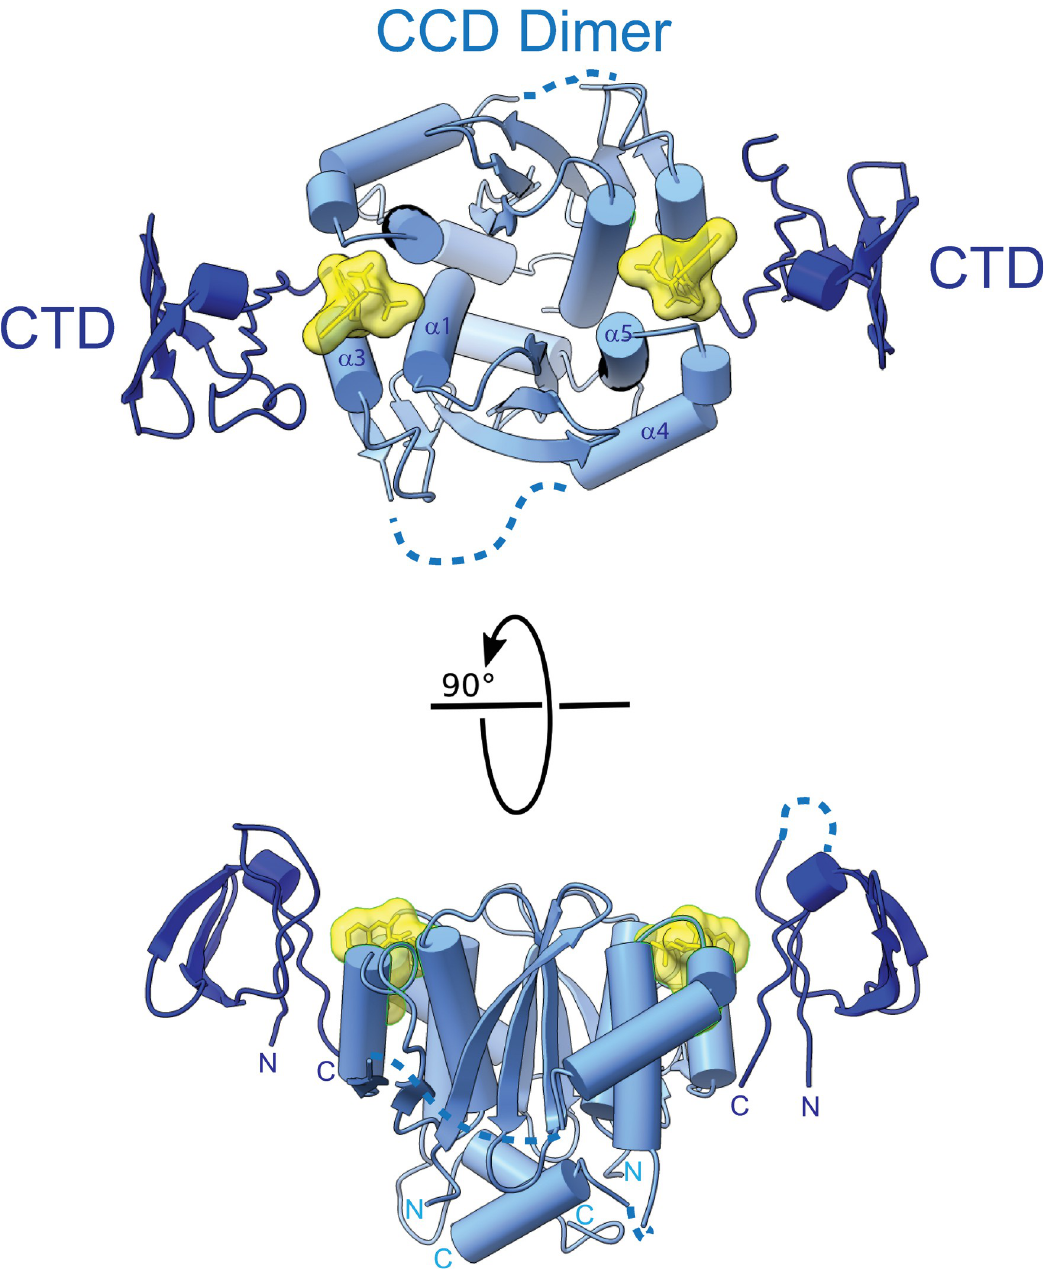
Fig 2. 2.93 Å X-ray Crystal Structure of CCD F185K •BI-224436•CTD. Orthogonal views of the 2:2:2 ternary complex. The CCD is colored in dark blue and the CTD is colored in light blue. The BI-224436 molecule is shown in yellow. Disordered linkers within the CCD and CTD not observed within the electron density are shown as dotted